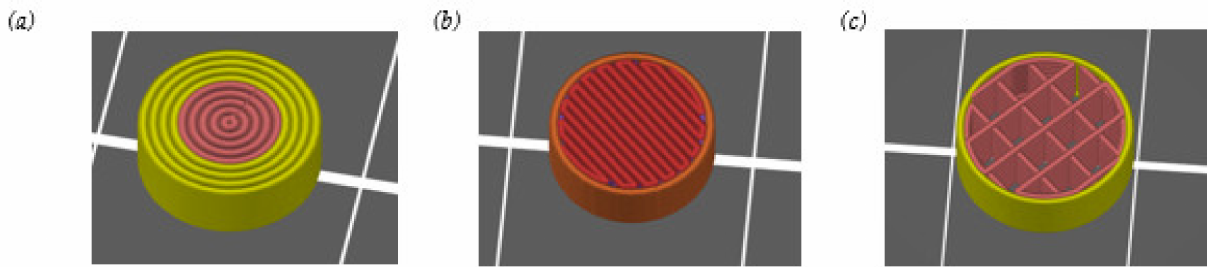
Figure 8. Design of different 3D printed tablets of the formulation containing bPMMA extruded at 70 ◦ C with 100 % infill ( a ), and reduced infill of 25 % ( b ) and 20 % ( c ).